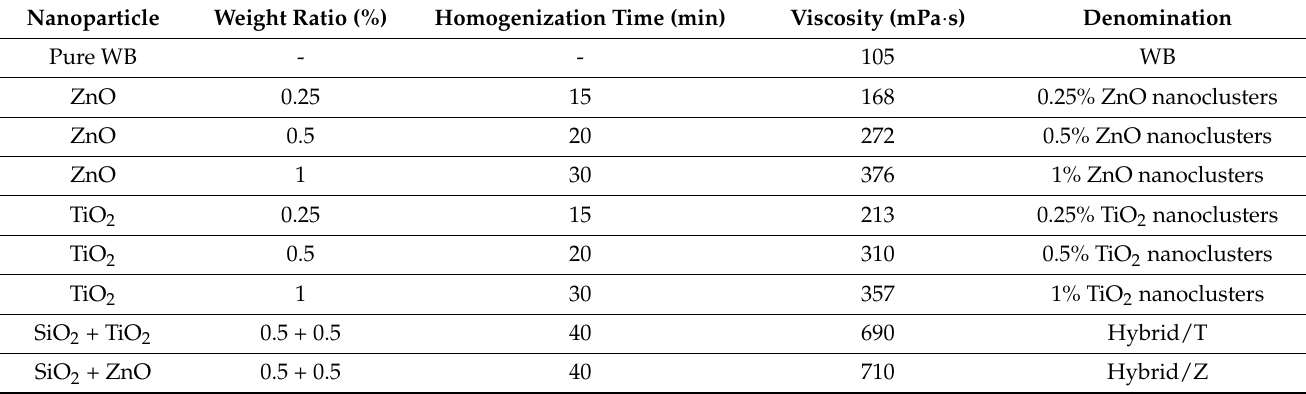
Table 1. Composition, homogenization time, and viscosity of prepared nanocomposites.